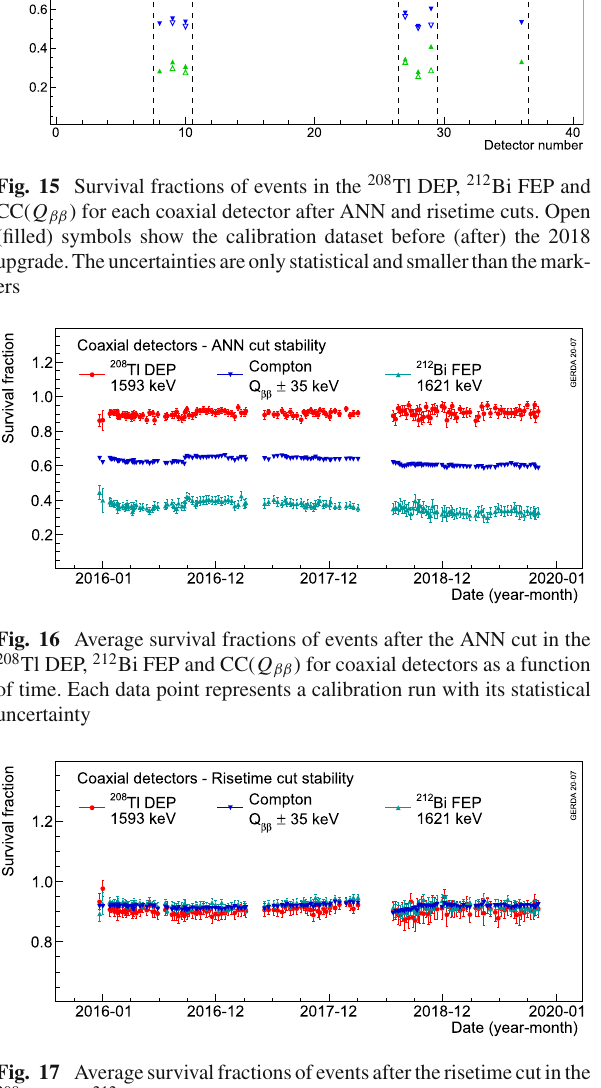
Fig. 17 Averagesurvivalfractionsofeventsaftertherisetimecutinthe 208 Tl DEP, 212 Bi FEP and CC( Q ββ ) for coaxial detectors as a function of time. Each data point represents a calibration run with its statistical uncertainty